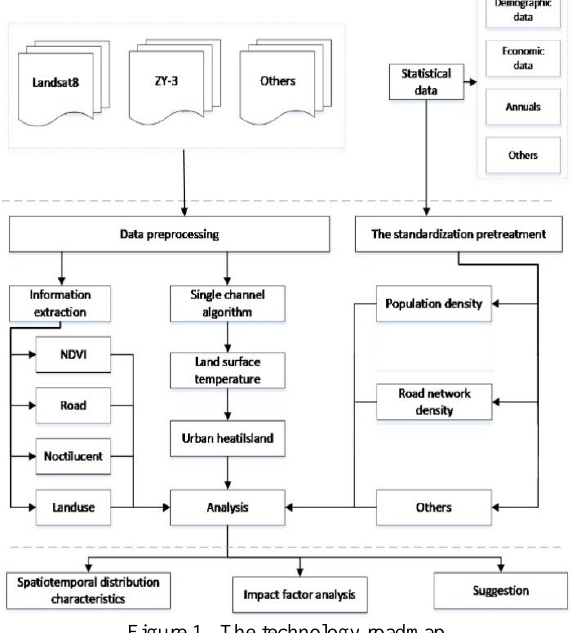
Figure 1. The technology